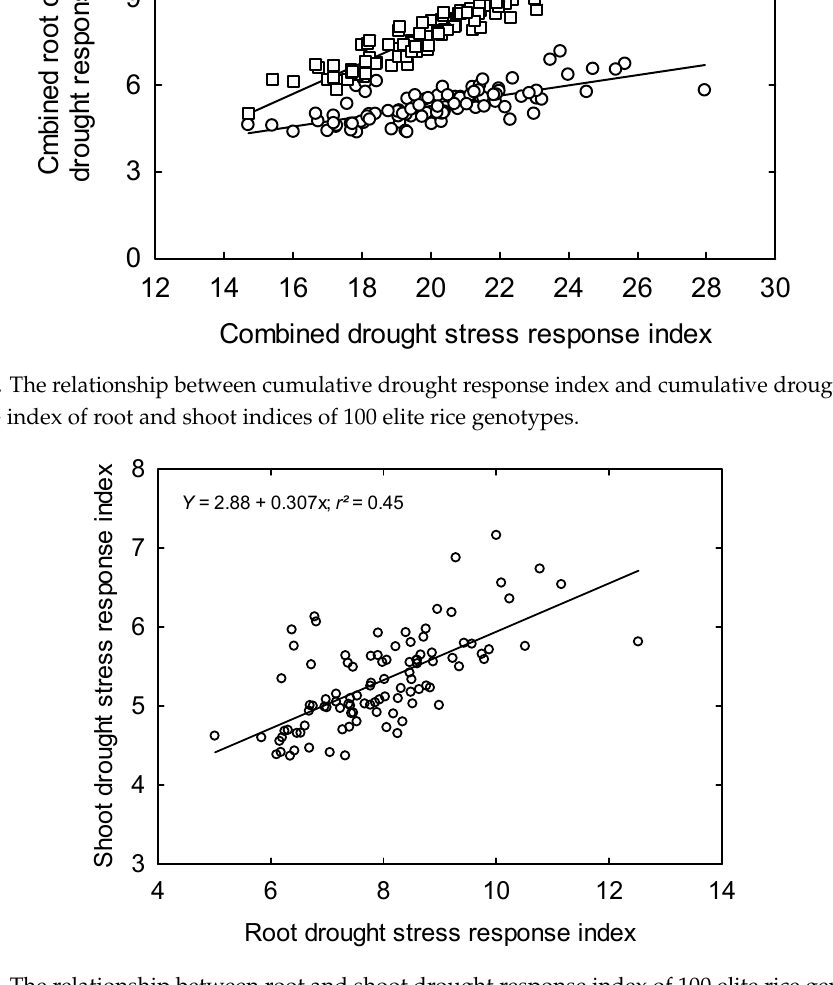
Figure 5. The relationship between root and shoot drought response index of 100 elite rice genotypes.